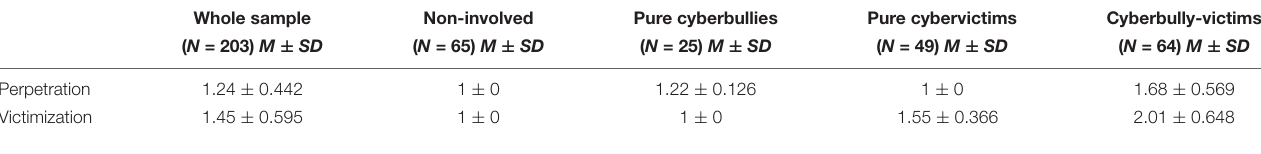
TABLE 2 | Means and standard deviations of cyberbullying involvement by cyberbully-victim group. Whole